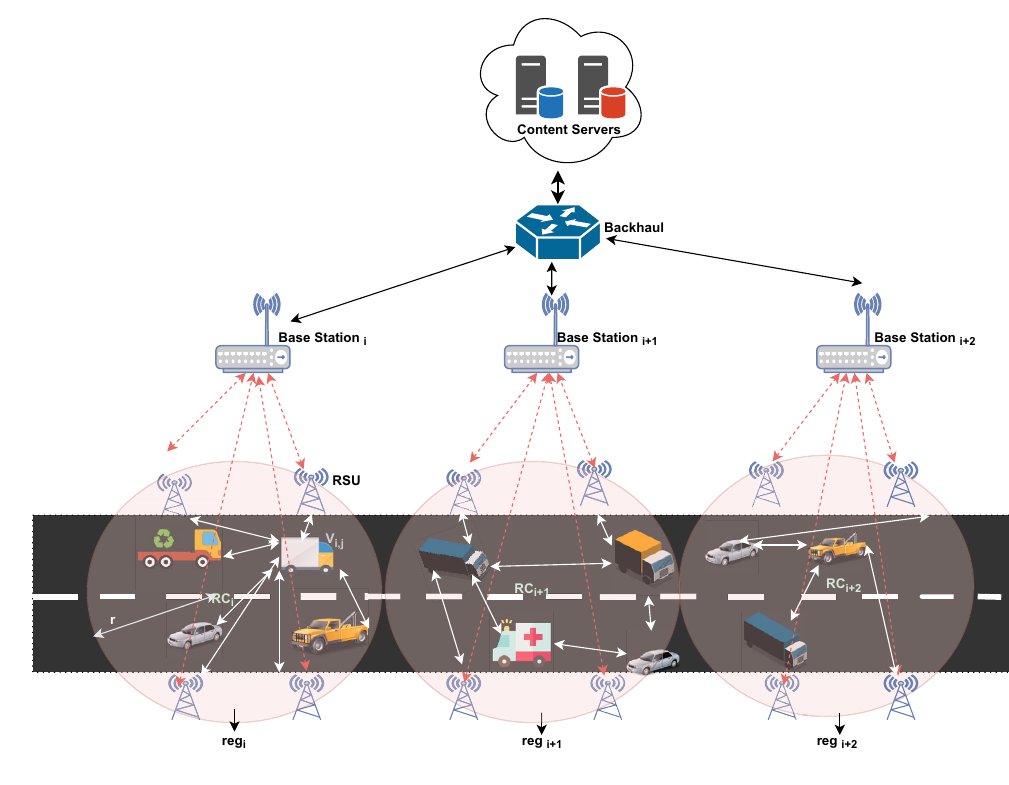
Figure 1. Region oriented network architecture.